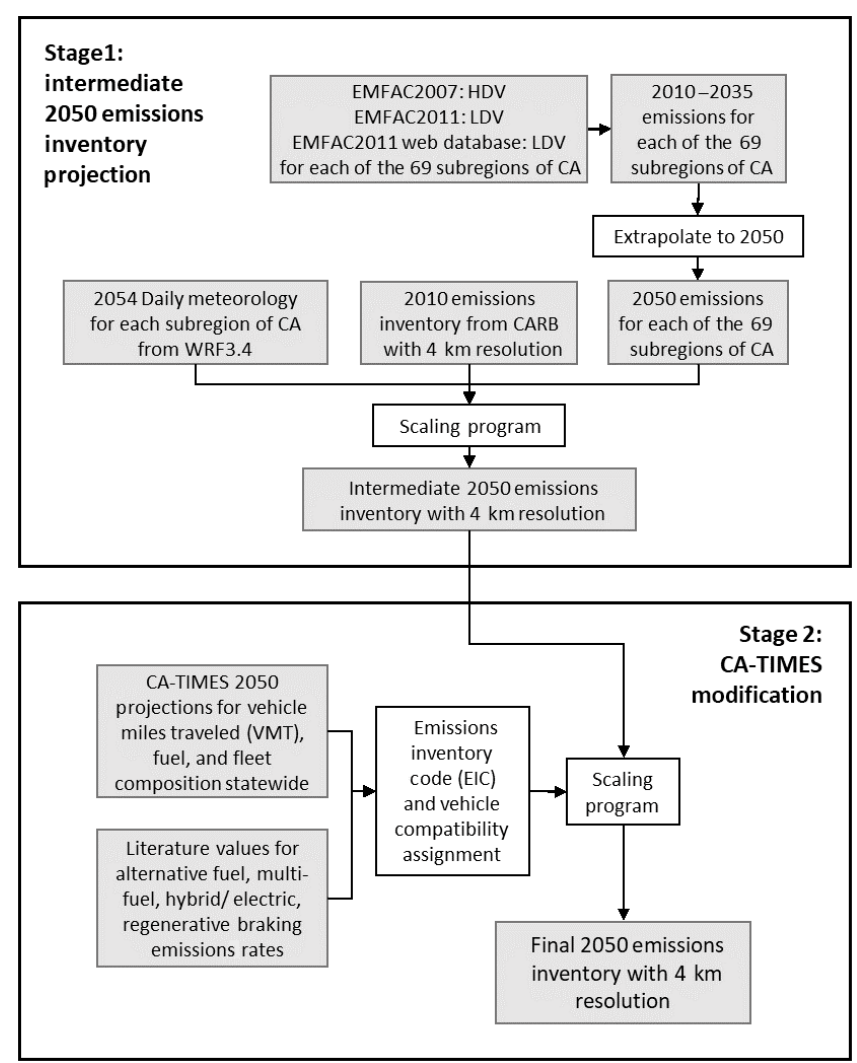
Figure 3. Simplified sequence of algorithms, calculations, and inputs used in developing the CA-TIMES alternative fuel on-road mobile emissions inventory per scenario. EIC is emissions inventory